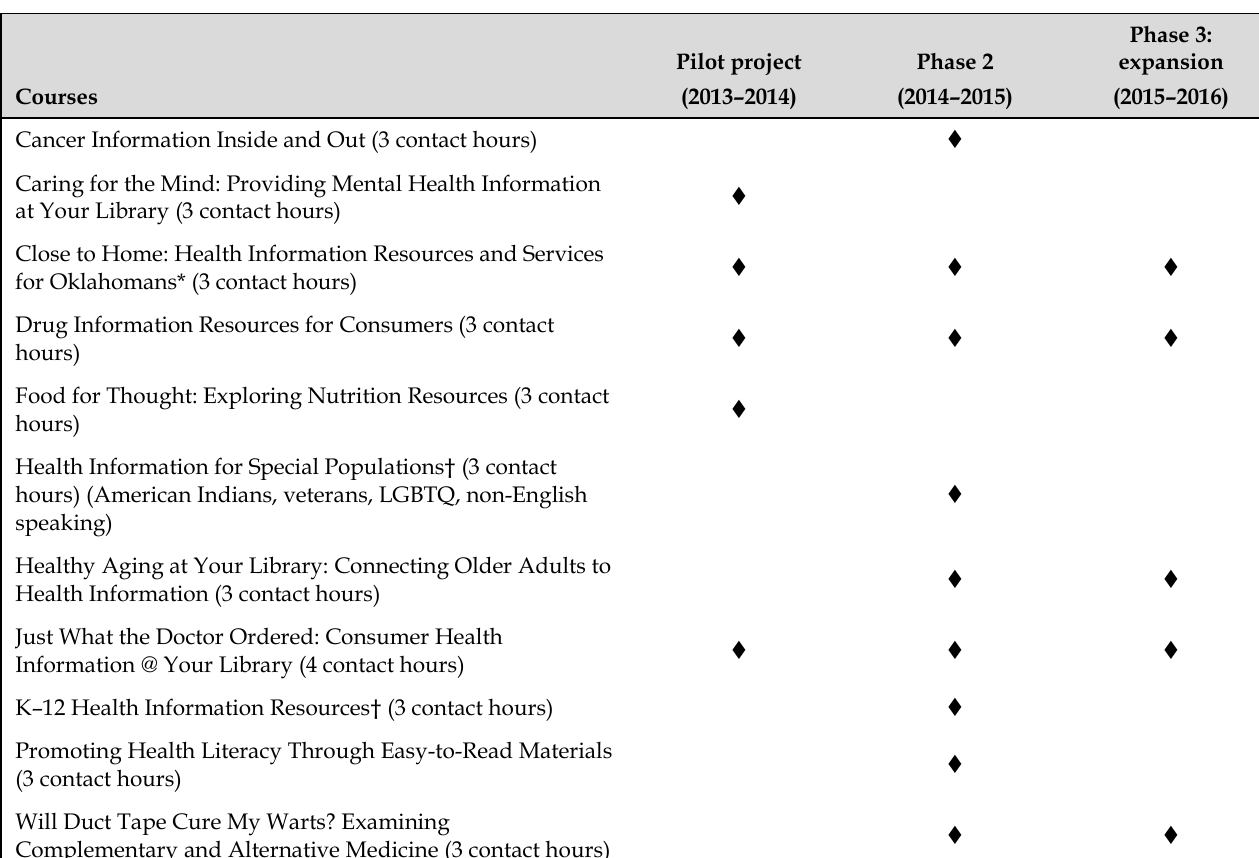
Table 2 Health Information Specialists Program: course